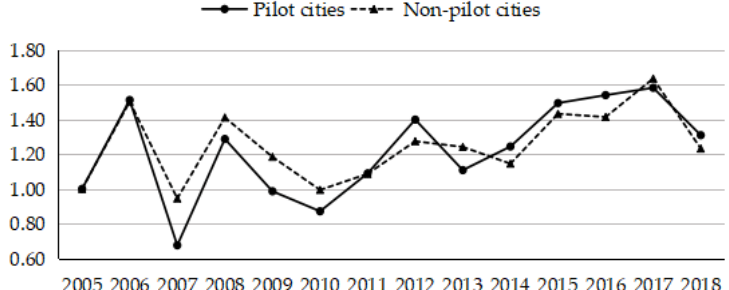
Figure 3. Time trends of urban GSDL between pilot cities and non-pilot cities.